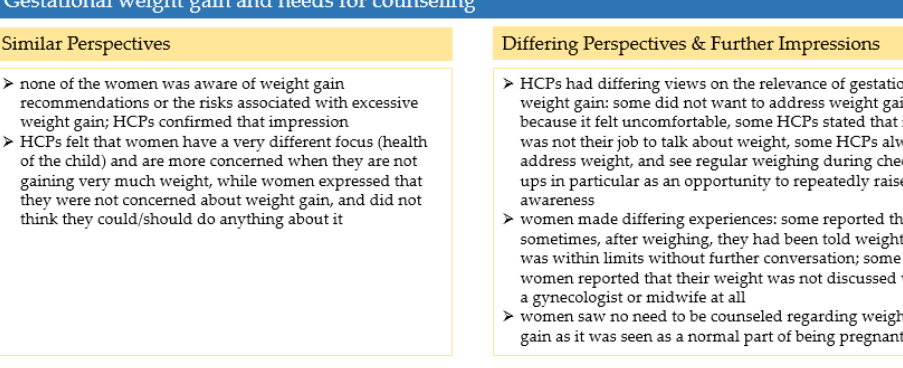
Figure 4. Summary of the results in Section 3.3.